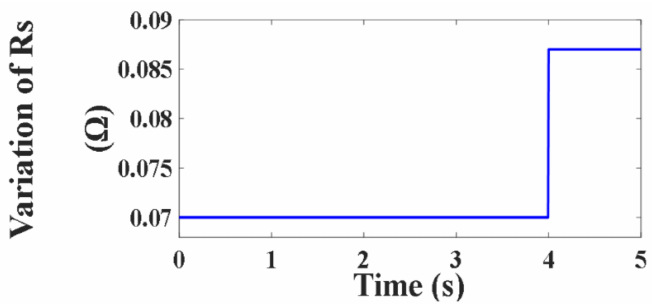
Figure 66. Variation of R s ( Ω